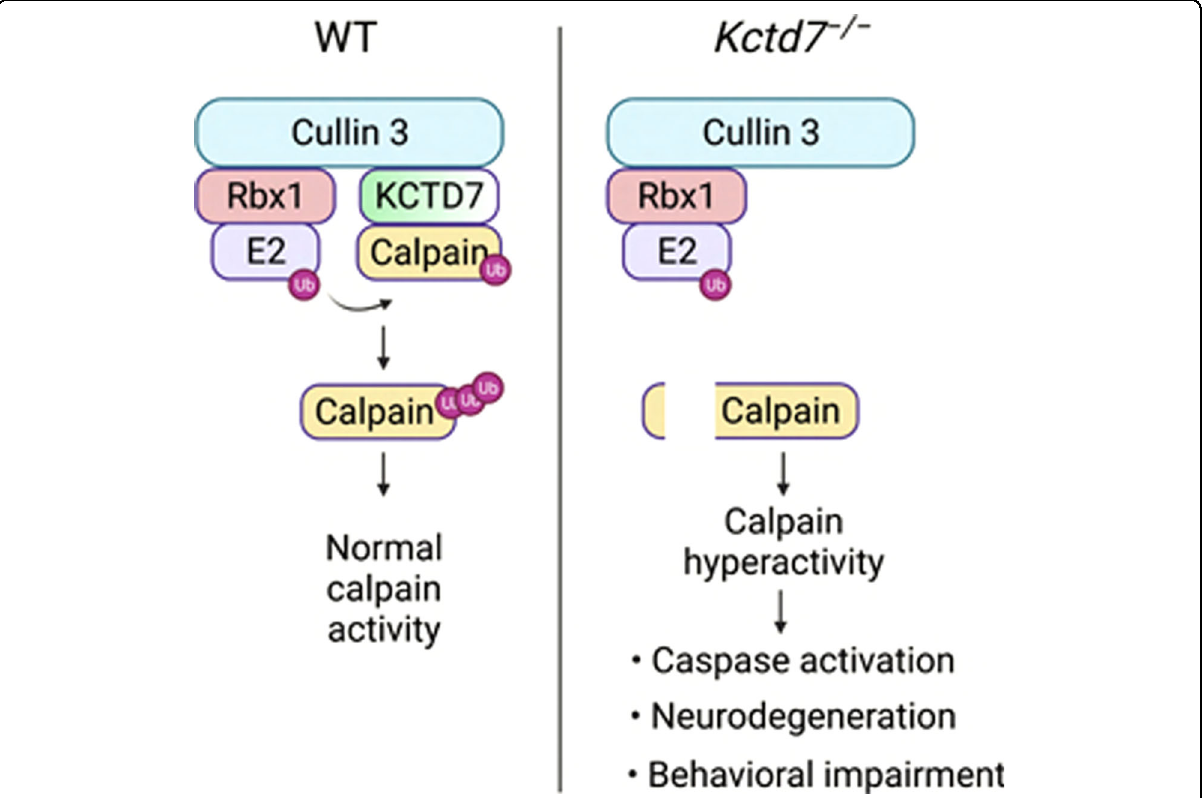
Fig. 9 Schematic model of calpain regulation by the Cullin-3 – RBX1 – KCTD7 complex. Shown is a comparison between WT conditions and de fi ciency of KCTD7 leading to calpain dysregulation and activation of a pathogenic